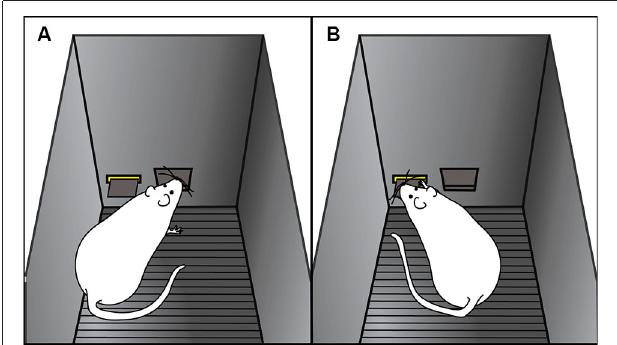
FIGURE 2 | Cartoon representation of goal-tracking and sign-tracking behaviors. Examples of (A) goal-tracking and (B) sign-tracking behaviors in response to lever-cue presentation during a Pavlovian conditioning session. (A) Goal-trackers approach the food cup (i.e., location of reward delivery) upon lever-cue presentation. (B) Sign-trackers approach the lever-cue during its presentation, even though no response is required for food